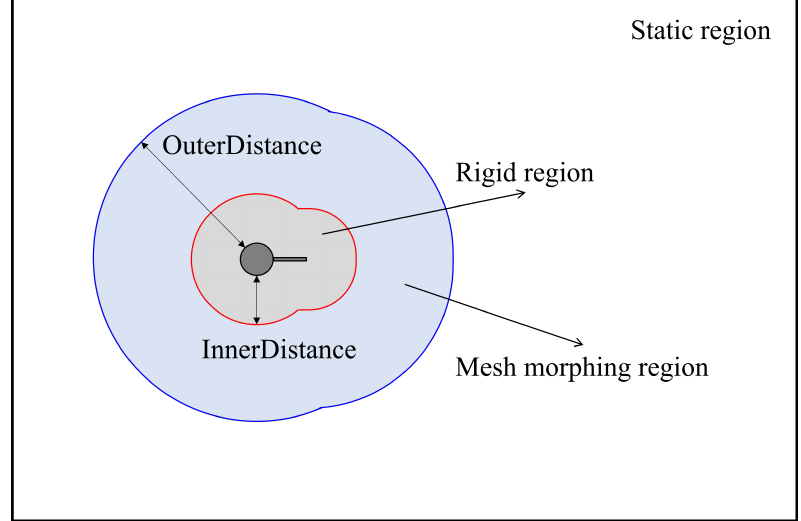
Figure 4. Partitioning of the computational domain into three regions by the specification of two parameters (innerDistance and outerDistance) in the dynamic meshing